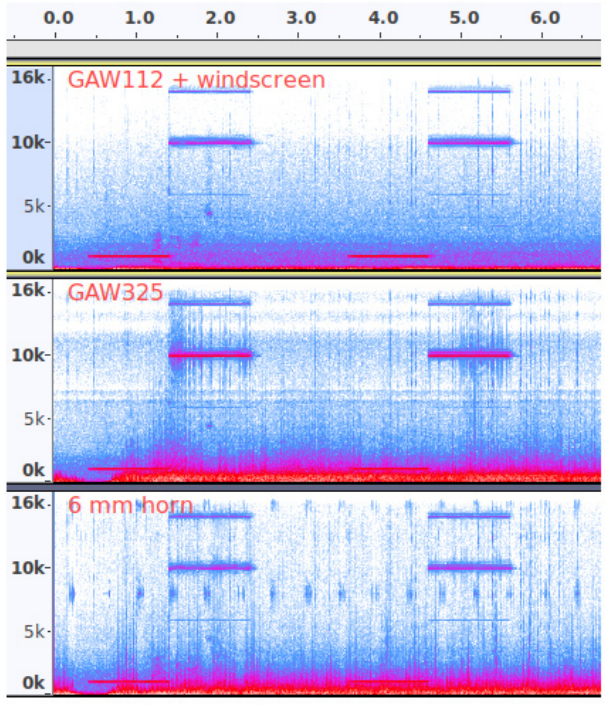
Figure 4. Spectrograms of different microphone designs (GAW112 and GAW325 are acoustic vents) showing wind noise. Without windscreen, 1 kHz test sounds are masked by wind